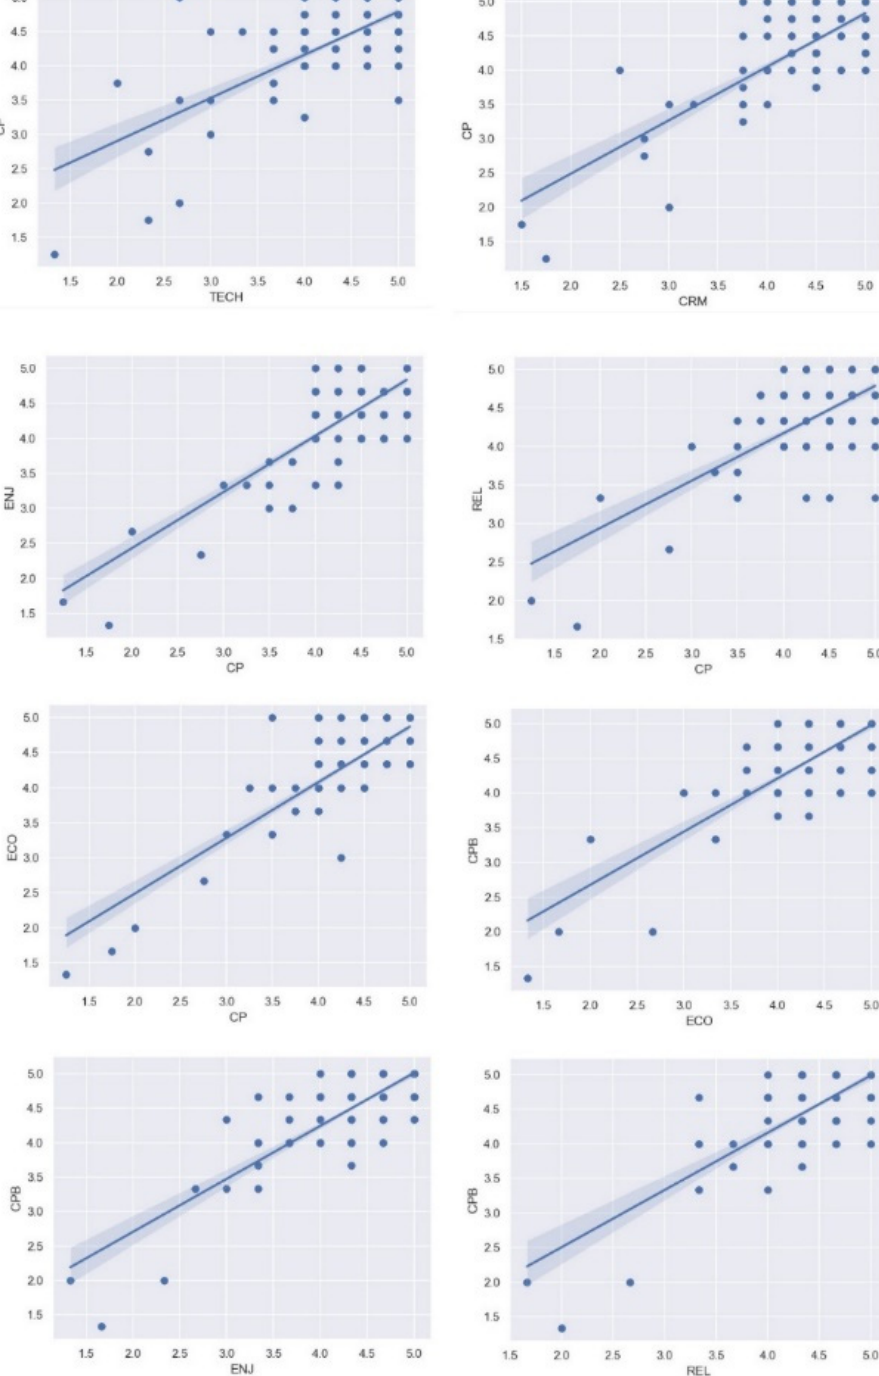
Figure 3. Scatter plots (hypotheses), based on the seaborn package of Python.